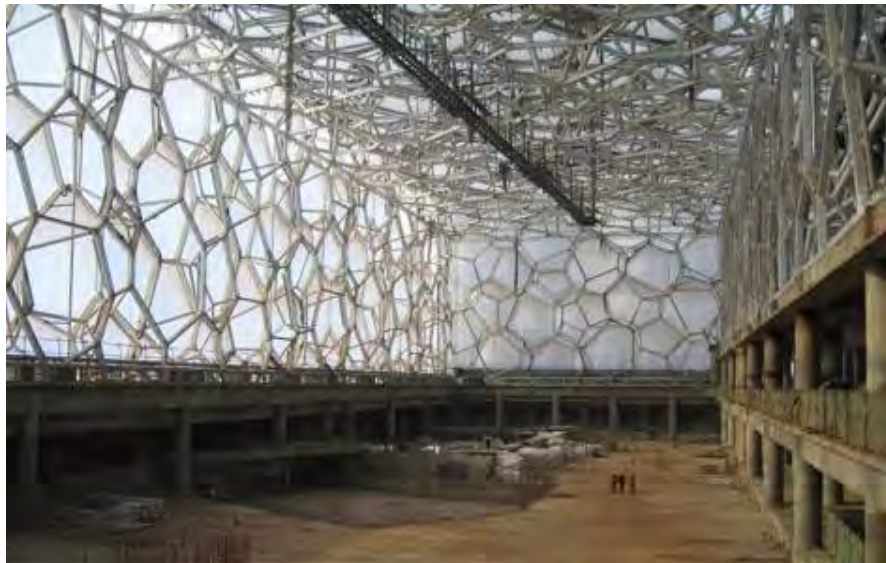
Figure 11. Watercube National Swimming Centre structure system,